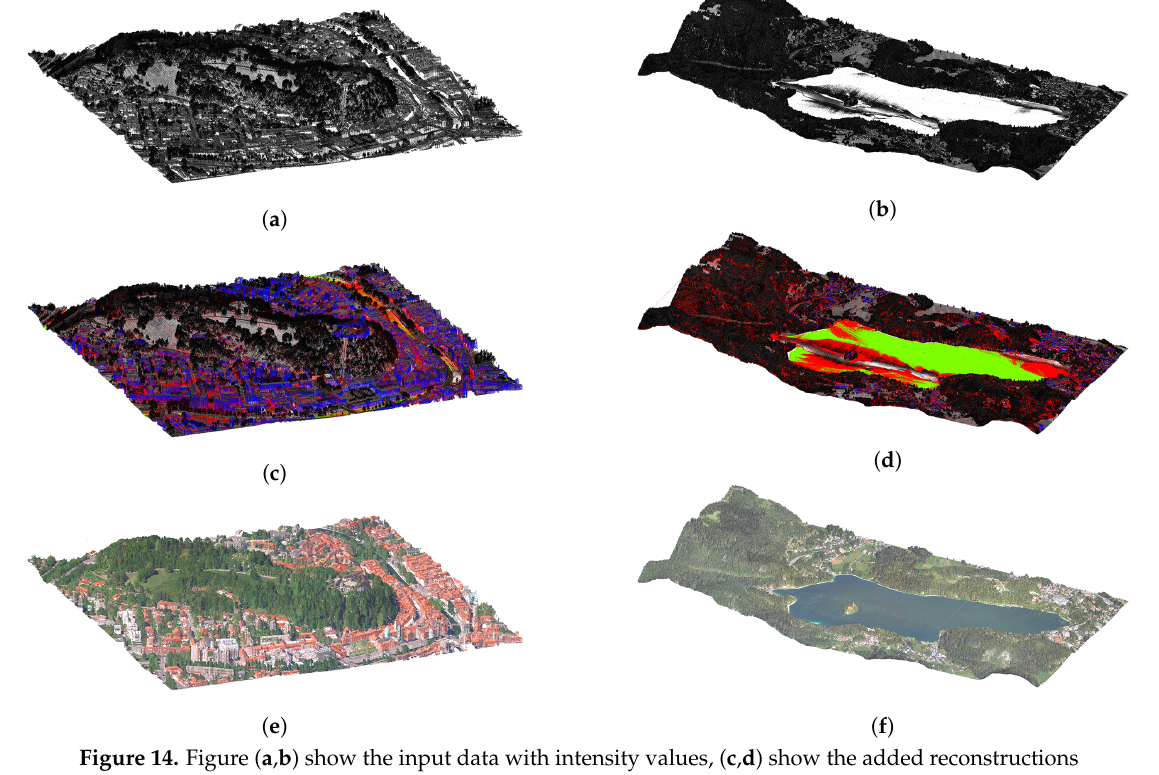
Figure 14. Figure ( a , b ) show the input data with intensity values, ( c , d ) show the added reconstructions (green—water surfaces, blue—building walls, and red—terrain reconstruction), and ( e , f ) show the final results with added colour information from orthophoto images and calculated